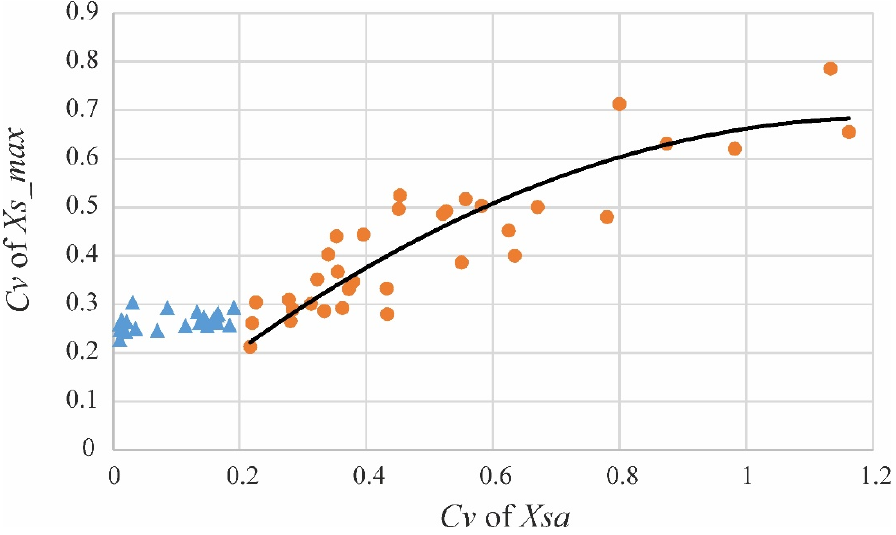
Figure 13. Effect of variability of total surface runoff X sa during snow thaw period on the variability Figure 13. E ff ect of variability of total surface runo ff X sa during snow thaw period on the variability of of the maximum daily runoff X s_max. the maximum daily runo ff X